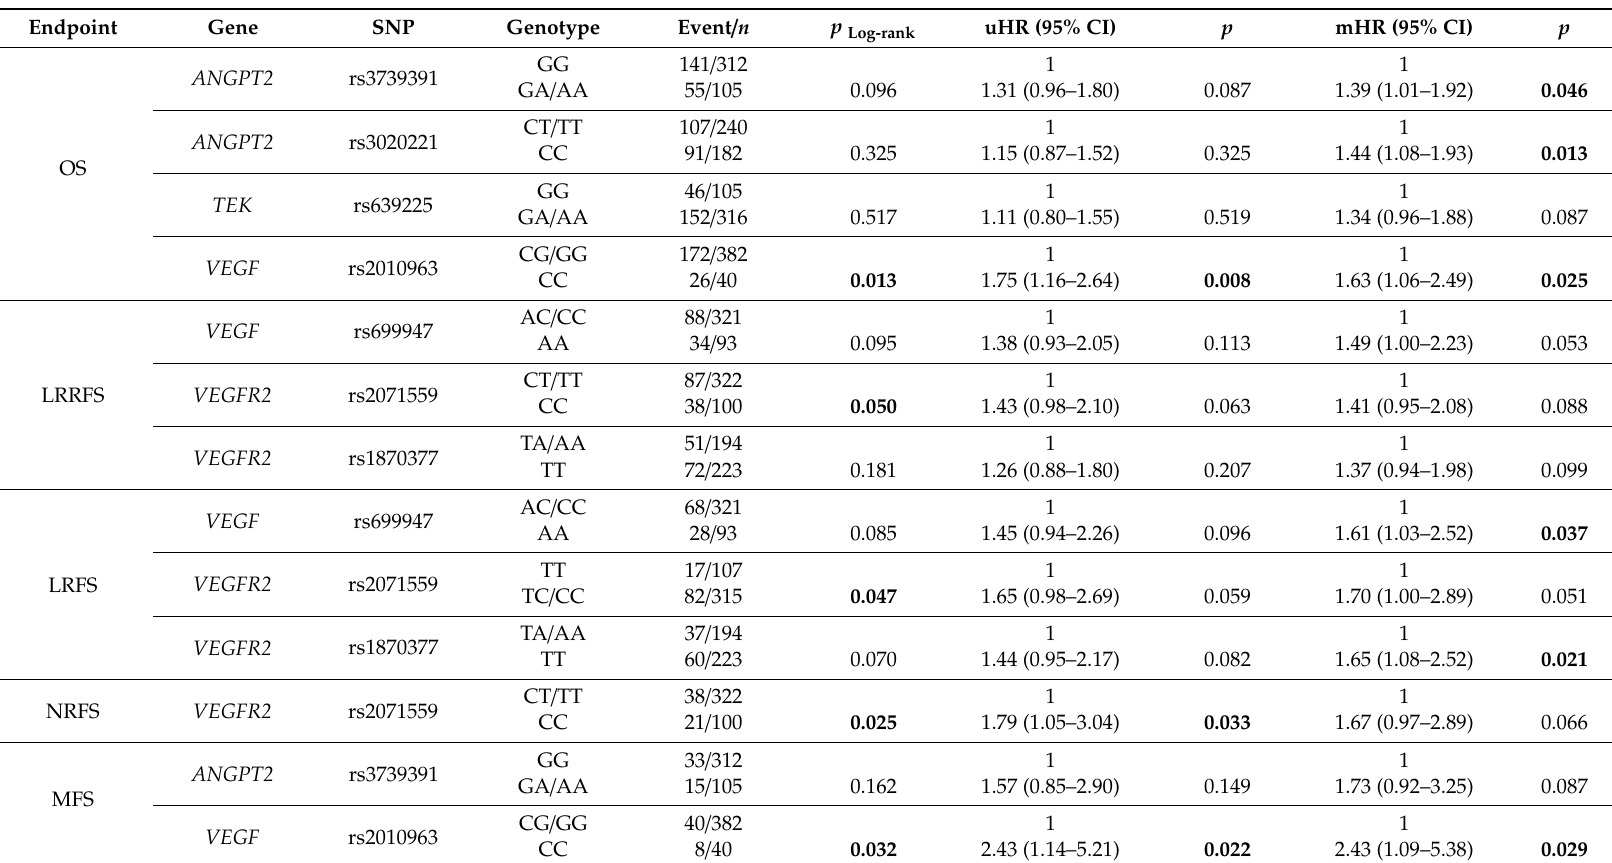
Table 2. Univariate and multivariate analysis in the whole group (only SNPs with p ≤ 0.05 in univariate models or p ≤ 0.100 in multivariate models without correction for multiple testing are